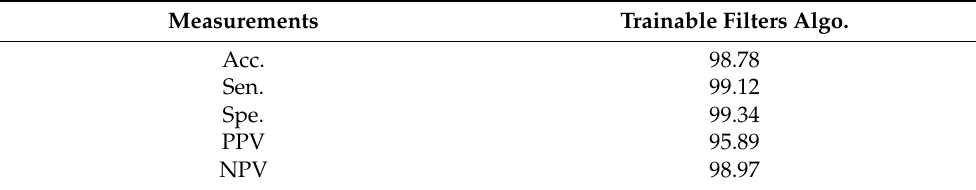
Table 4. Performance comparison of the trainable filter algorithms on the HRF dataset.